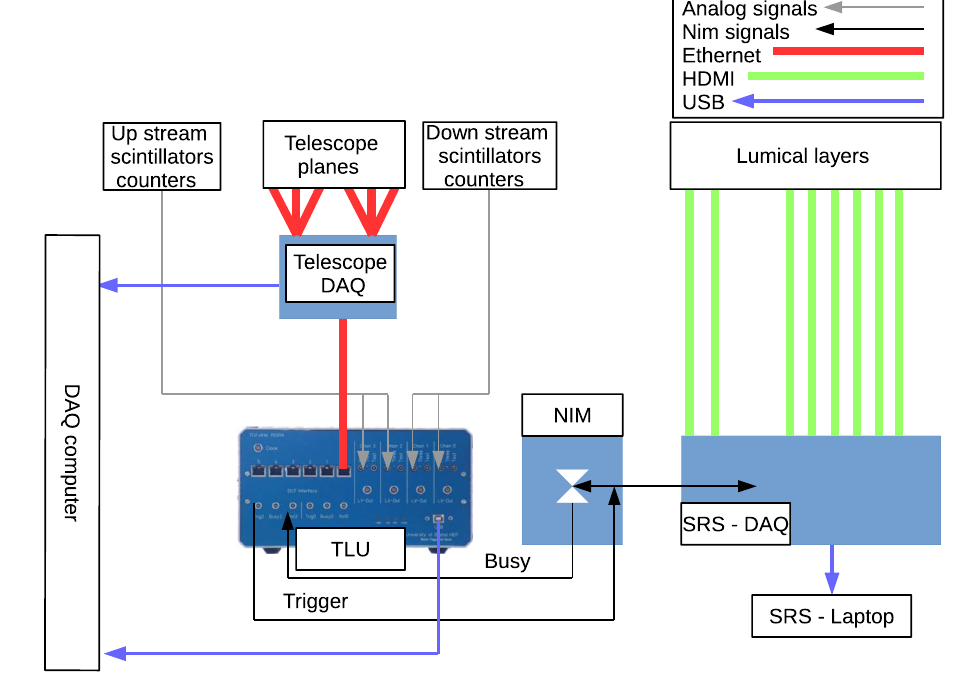
Fig. 7 The data acquisition system m long HDMI cables. These samples are converted to 12-bit numbers in the SRS adapter board and transmitted to the data acquisition